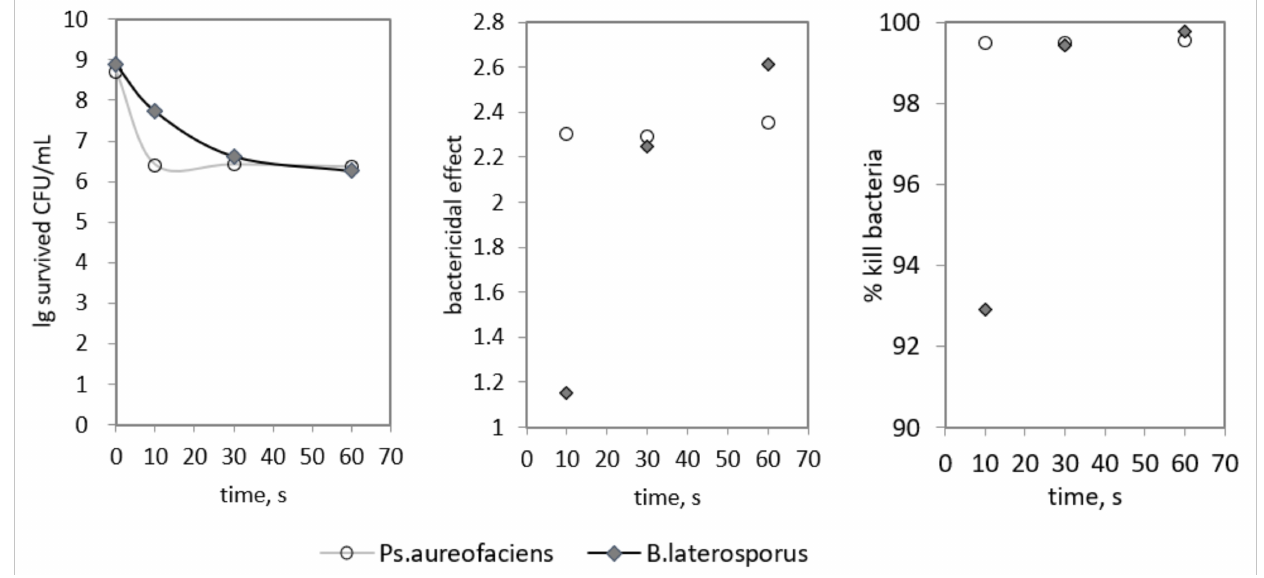
Figure 3. Survival curves of Pseudomonas aureofaciens AP-9 and Brevibacillus laterosporus BT-271 ( left ), the bactericidal effect of plasma ( middle ), and percentage bacteria killed ( right ) at different treatment